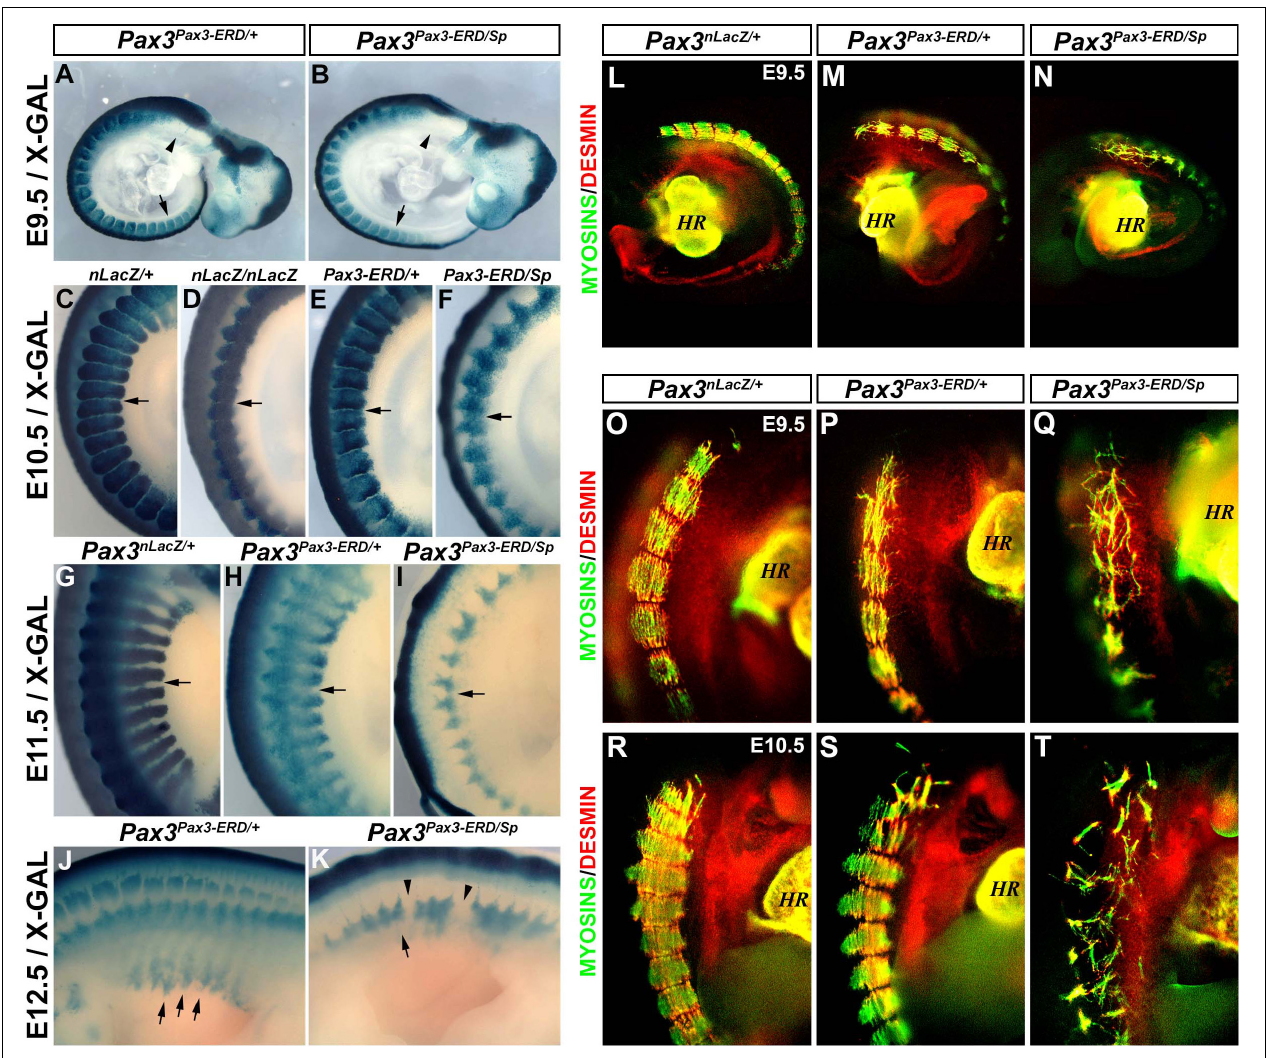
FIGURE 3 | Characterization of the myotome of Pax3 Pax 3 - ERD / + and Pax3 Pax 3 - ERD / Sp embryos. (A,K) X-GAL staining of whole-mount control ( Pax3 nLacZ / + ) (C,G) , Pax3 -mutant ( Pax3 nLacZ / nLacZ ) (D) , Pax3 Pax 3 - ERD / + (A,E,H,J) , and Pax3 Pax 3 - ERD / Sp (B,F,I,K) embryos at E9.5 (A,B) , E10.5 (C–F) , E11.5 (G–I) , and E12.5 (J,K) . (L–T) Whole-mount immunostaining to visualize muscle Myosins (green) and Desmin (red) in control ( Pax3 nLacZ / + ) (L,O,R) , Pax3 Pax 3 - ERD / + (M,P,S) and Pax3 Pax 3 - ERD / Sp (N,Q,T) embryos at E9.5 (L–Q) and E10.5 (R–T) (HR,